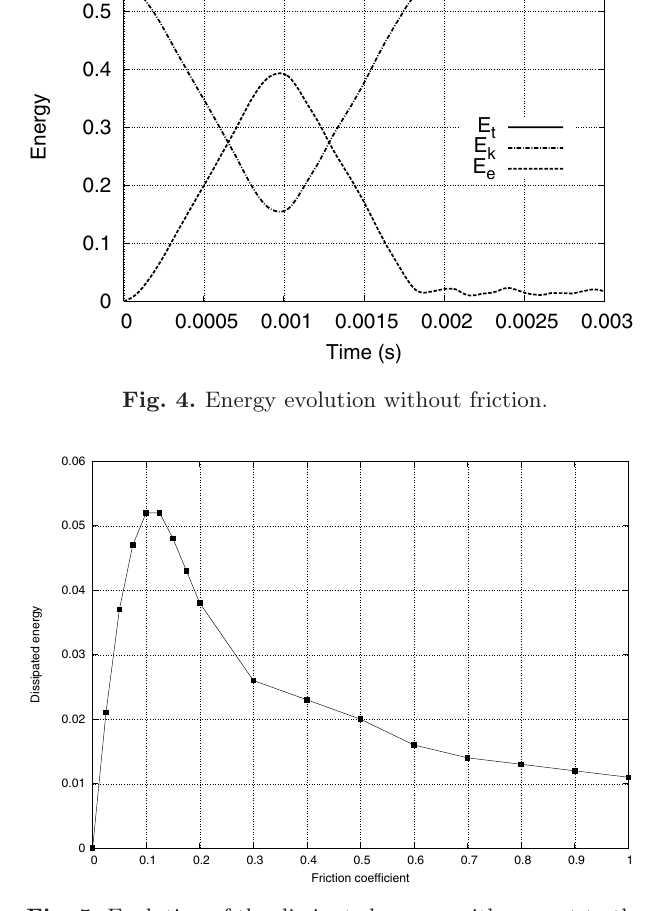
Fig. 5. Evolution of the dissipated energy with respect to the friction coefficient.